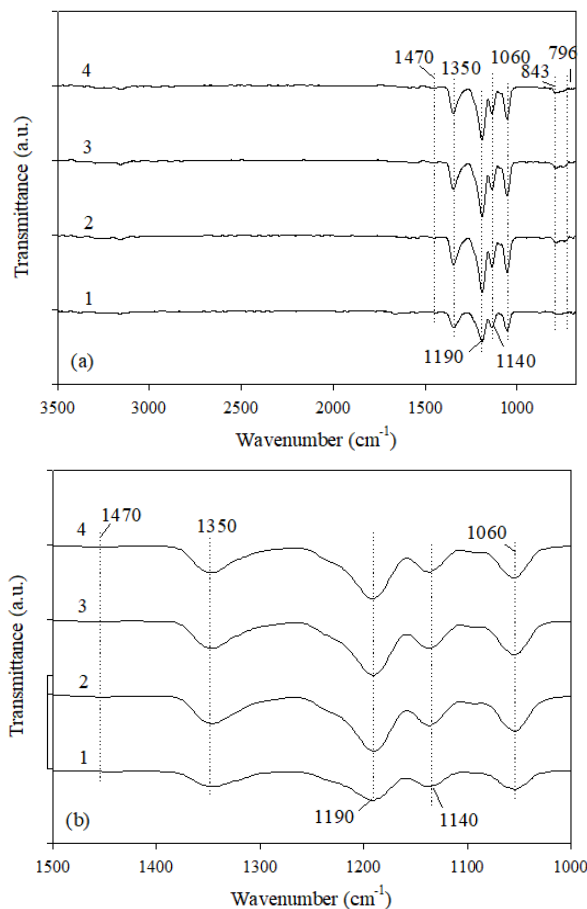
Figure 1. FTIR spectra of synthesized ionic liquids in the range of ( a ) 680–3500 cm − 1 and ( b ) 1000–1500 cm − 1 : (1) MIM-TFSI, (2) EIM-TFSI, (3) PIM-TFSI and (4) BIM-TFSI.